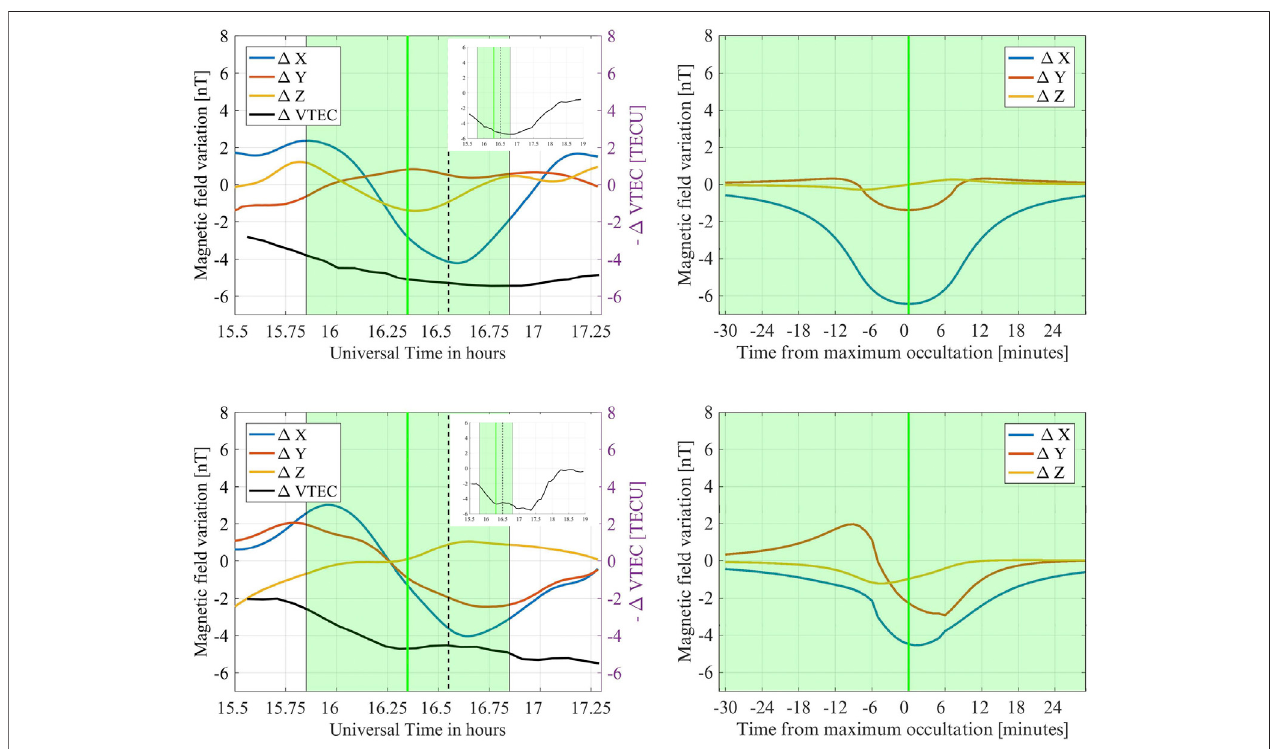
FIGURE5| GeomagneticvariabilitydetectedfromVCH (top) andTRW (bottom) observatories.Theleft-handcolumnshowsthemeasurementsof Δ X, Δ Y,and Δ Z variations.Theirintensitiesarelabeled intheleft-hand y -axis. Theblackcurveshows Δ VTECmeasurementswithTECUintensitieslabelled intheright-handaxis.Thetop right-hand inset graphs in both panels show Δ VTEC behaviour over a longer time interval. The right-hand column shows the geomagnetic variability based on the Ashour-Chapman thin current sheet model.